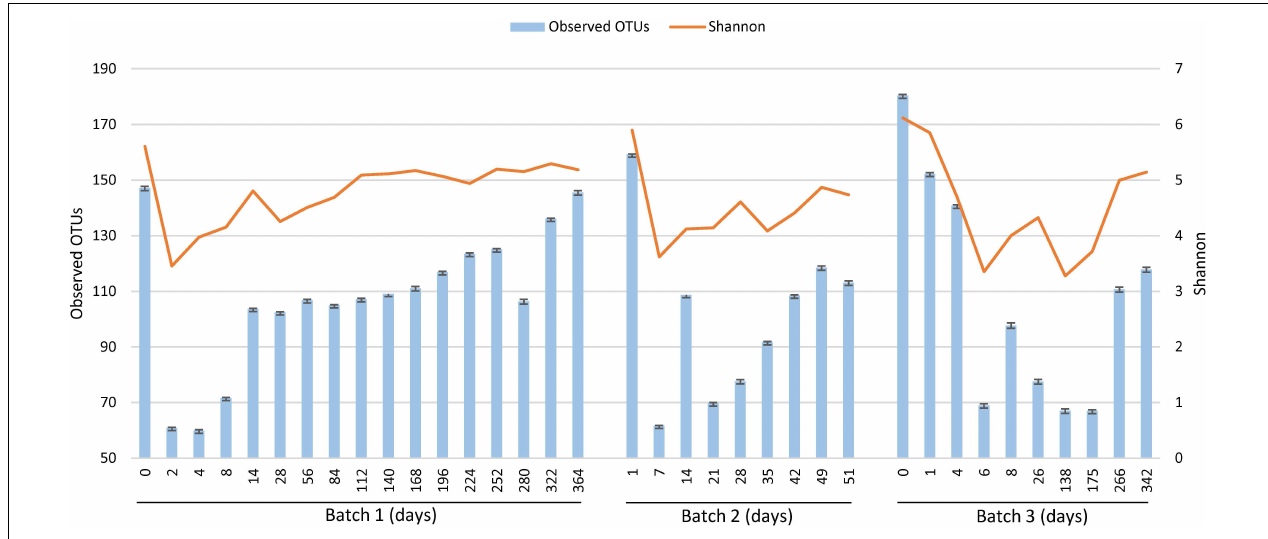
FIGURE 3 | Changes in alpha diversity [observed operational taxonomic units (OTUs) and Shannon index of diversity (Shannon, 1948)] depending on the fermentation period, analyzed using the Divisive Amplicon Denoising Algorithm (DADA2) based on the fermentation period. The 16S rRNA sequencing depth is 6,000 for each sample. The number corresponding to the depth was according to the read number for the coverage of all